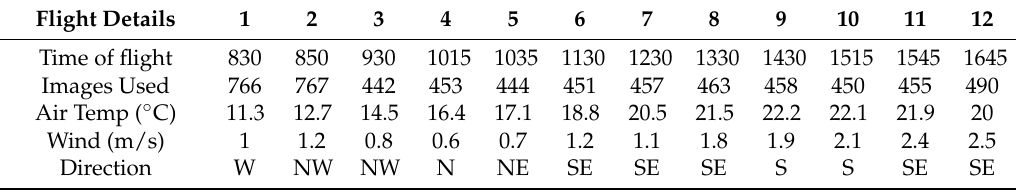
Table 2. Flight characteristics and meteorological conditions for 31 January 2017 campaign.